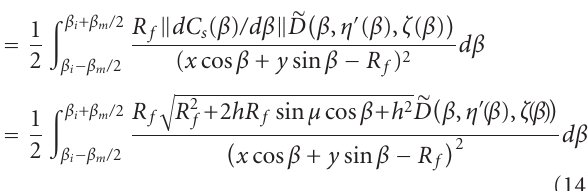
We use Turbell clock phantom and thorax phantom to eval- uate the performance of the proposed algorithm. Parameters of the simulation are set to R f = 570mm, R d = 560mm, S = 1mm, p = 1 . 0, projection number per rotation N p = 1024, number of detector cells for each row N f = 800, detec- tor cell width 1 . 5mm, gantry-tilted angle μ = 10 ◦ . The sim- ulated performance of the proposed algorithm is compared with two existing approximate gantry-tilted CT reconstruc- tion algorithms, which are the gantry-tilted FDK algorithm in [3] by Hein et al. in 2003 and the gantry-tilted ASSR [2] by Kachelrei β et al in 2001. The Turbell clock phantom is used to evaluate the pro- posed algorithm. The Turbell clock phantom is composed with a cylinder and two group balls. The radius of the cylin- der is 240mm and its centre is (0,0,0) and its length is 100mm and its value is 0.4. The radius of the outer group balls is 22mm and their values are 1.0. The radius of inner group balls is 12mm and their values are 1.0. The positions of these balls are listed in Table 1. Results obtained from the simulation of Turbell clock phantom are shown in Figure 5, the left column is reconstructed images and the right col- umn is the centre vertical line for reconstructed images. In Figure 5, Figure 5(a) is the image reconstructed by our pro- posed algorithm, Figure 5(c) is reconstructed by the gantry- tilted FDK algorithm and Figure 5(e) shows the image recon- structed by the gantry-tilted ASSR. The results demonstrate that the image reconstructed by our proposed algorithm con- tains fewer artifacts than that of the other two existing algo- rithms for gantry-tilted CT. In the simulation of Turbell clock phantom, the centre vertical lines ( y = 0mm) for the reconstructed images are also constructed and displayed by the proposed algorithm (Figure 5(b)), gantry-tilted FDK algorithm (Figure 5(d)), and gantry-tilted ASSR (Figure 5(f)), repectively. In Figure 5, dashed lines represent the original image and solid lines rep- resent reconstructed profiles. The results show that the pro- file of the proposed algorithm as shown in Figure 5(b) has smaller variance than the other two results.